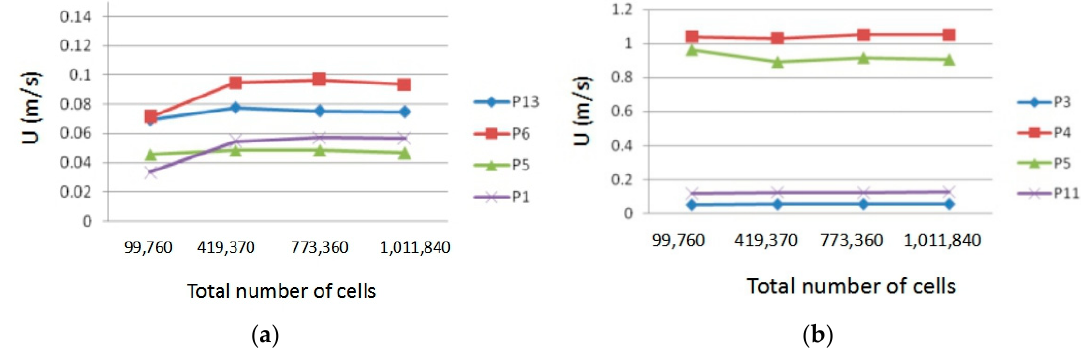
Figure 3. Results of grid independent test. ( a ) Case A; ( b ) case B.